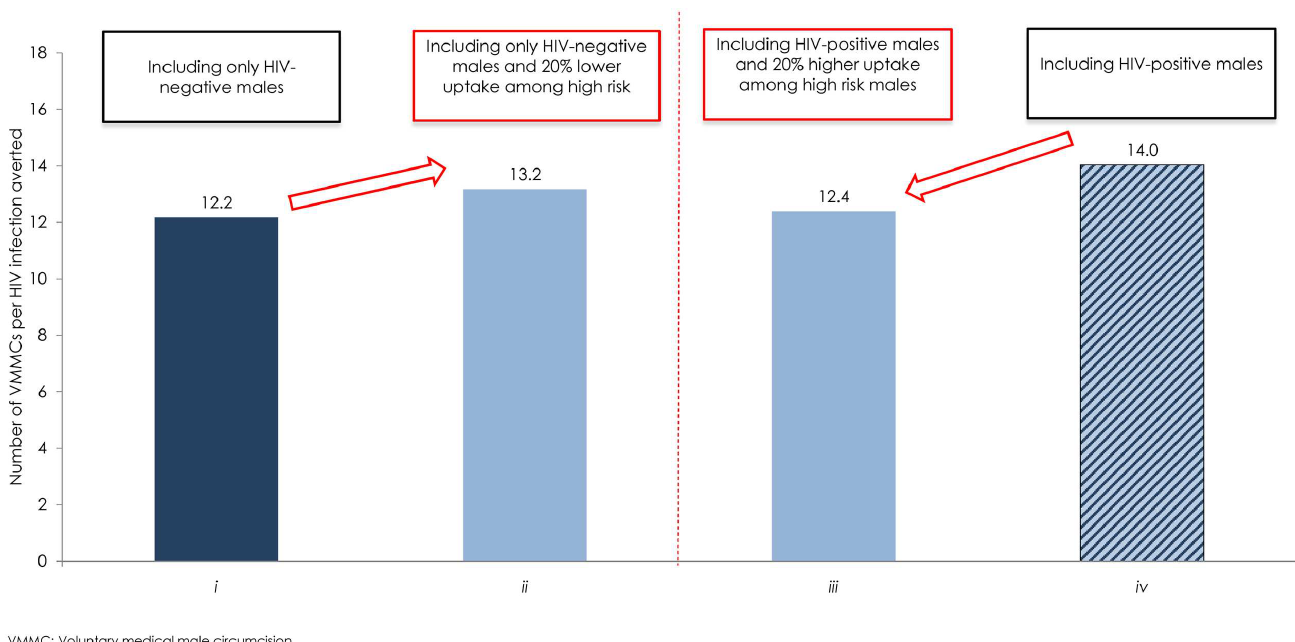
Fig 3. Effectiveness of the VMMC program in Zambia at different uptake levels among higher-risk males. The figure shows the effectivenessof the VMMC program including i ) only HIV-negative males, ii ) only HIV-negative males, but with 20% lower uptake of VMMC among higher-risk males, iii ) proportionof HIV-positive males, based on their representation in the population,but with 20% higheruptake of VMMC among higher-risk males, and iv ) proportionof HIV-positivemales, based on their representation in the population.No efficacy of male circumcision against male-to-female HIV transmission was assumed. Effectiveness is definedas the numberof VMMCs neededto avert one HIV